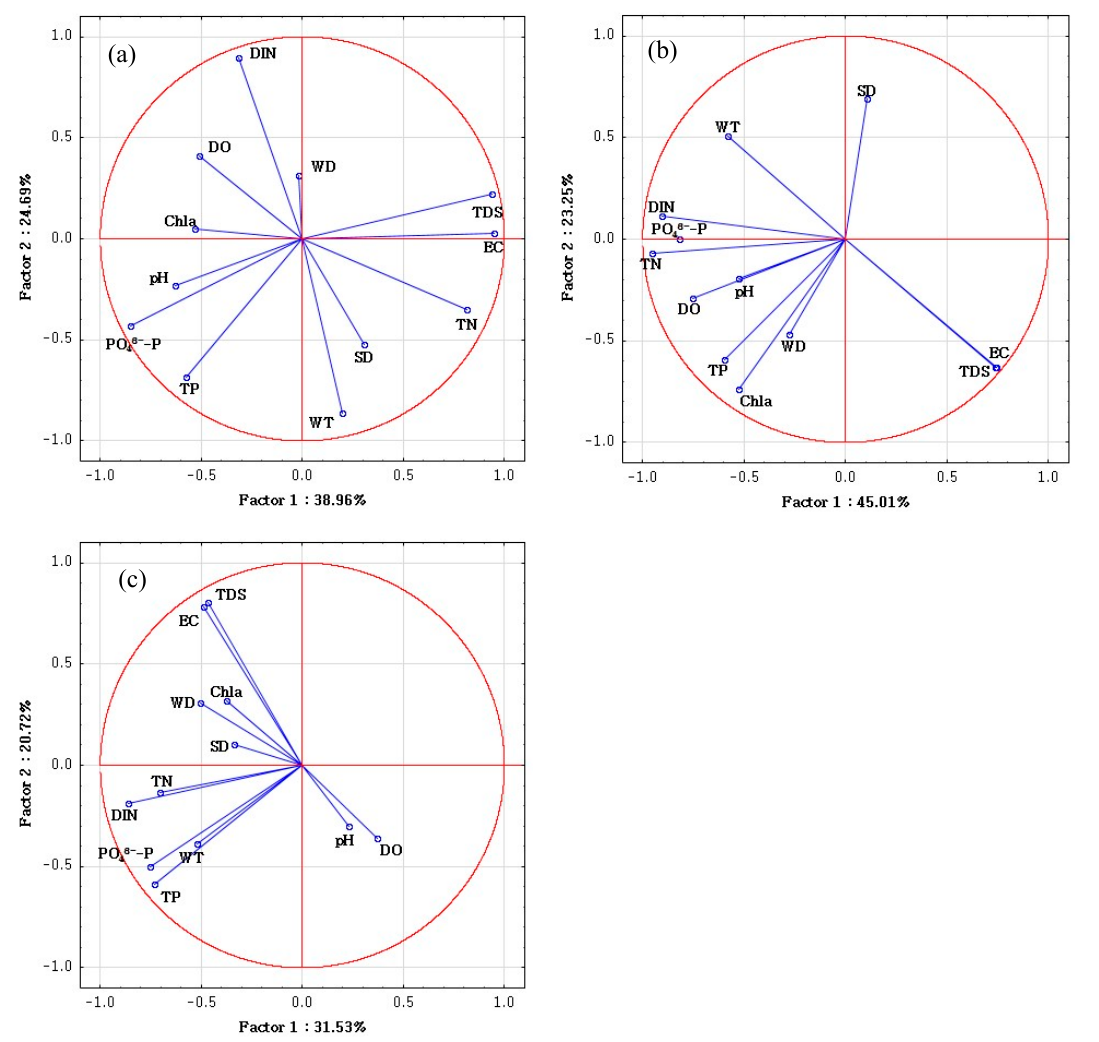
Figure 6. ( a ) PCA of cluster 1 of temporal CA; ( b ) PCA of cluster 2 of temporal CA; ( c ) PCA of cluster 3 of temporal CA. Table 8. Component loadings of each parameters and cumulative variance of the principal components.